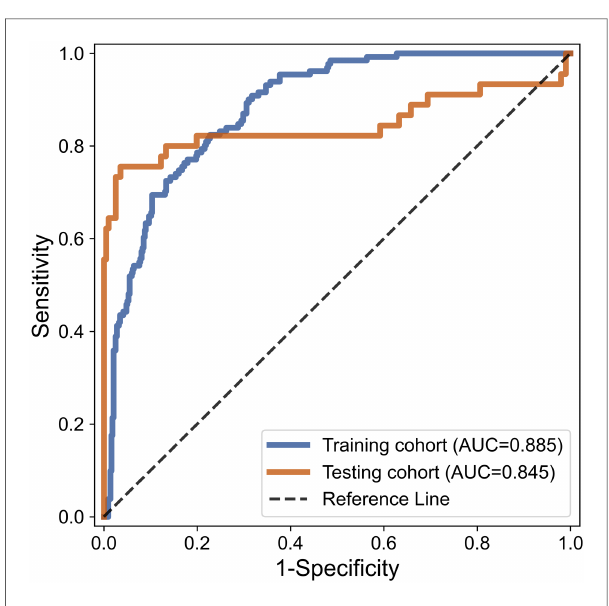
FIGURE 6 ROC curves of SVM based C-SVC for WMI status prediction in the training and testing set.